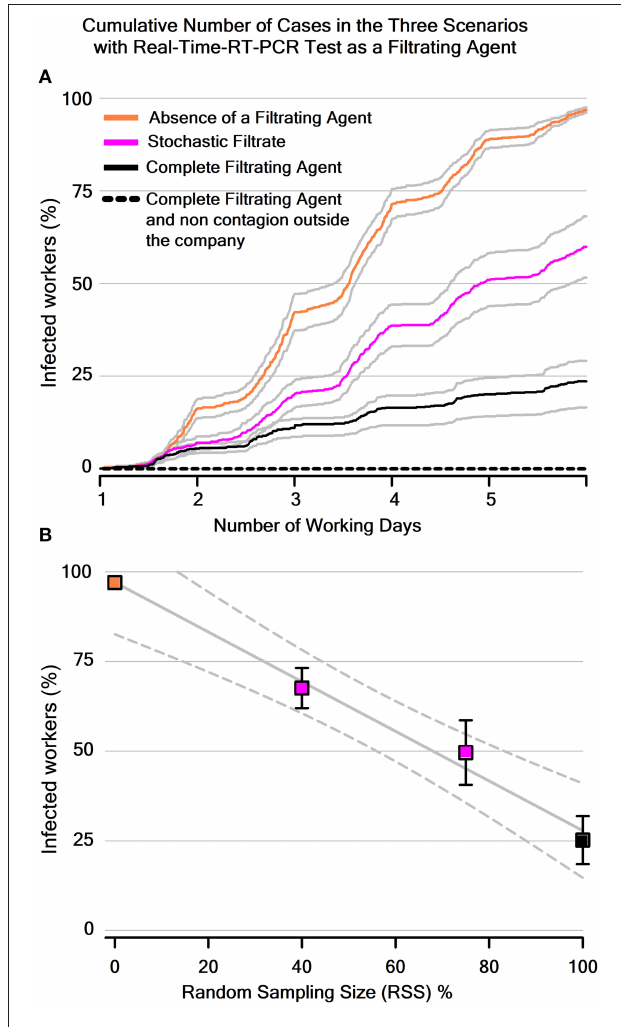
FIGURE 4 | Cumulative mean number of cases of infected workers in the three scenarios: absence of a filtrating agent, complete filtrating, and stochastic filtrate. Quantitative results from the Python simulation for 15 different companies. (A) Superimposed graphs show the number of infected workers (as a percentage of the total number of workers) in the absence of a filtrating agent, complete filtrating, and stochastic filtrate. Note the effectivity of the stochastic filtrate of workers compared with the lack of a filtrating agent. Gray lines indicate the standard error of the mean. In the real situation, the time between “working days” could be defined empirically. These are simulated strategies with real-time-RT-PCR as a filtrating agent, but other filtrate agents detecting SARS-CoV-2 could be employed. (B) Number of infected workers (as a percentage of the total number of workers) vs. random sampling size (RSS in %) employed to generate the three scenarios in the Python simulation. Note that the number of infected workers is inversely proportional to RSS. The graph also shows that the stochastic process is between two deterministic situations: “absence of a filtrate agent” and “complete filtrate agent,” with an uncertainty range to quantify the number of infected workers for intermediate values of RSS (with 95% confidence intervals, dashed lines). Vertical bars represent the standard